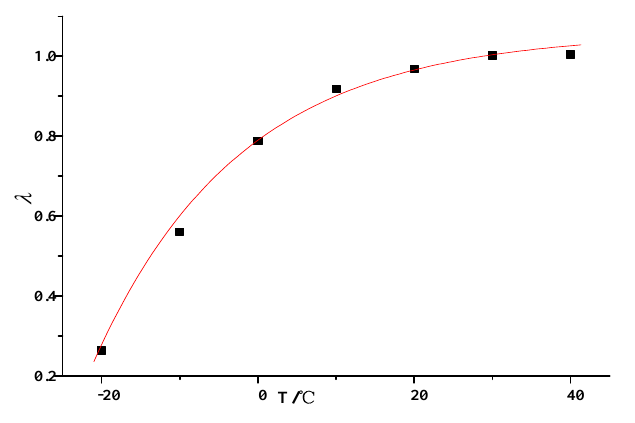
Figure 7. The value λ of at di ff erent temperature. Table 5. Parameter identification of λ .